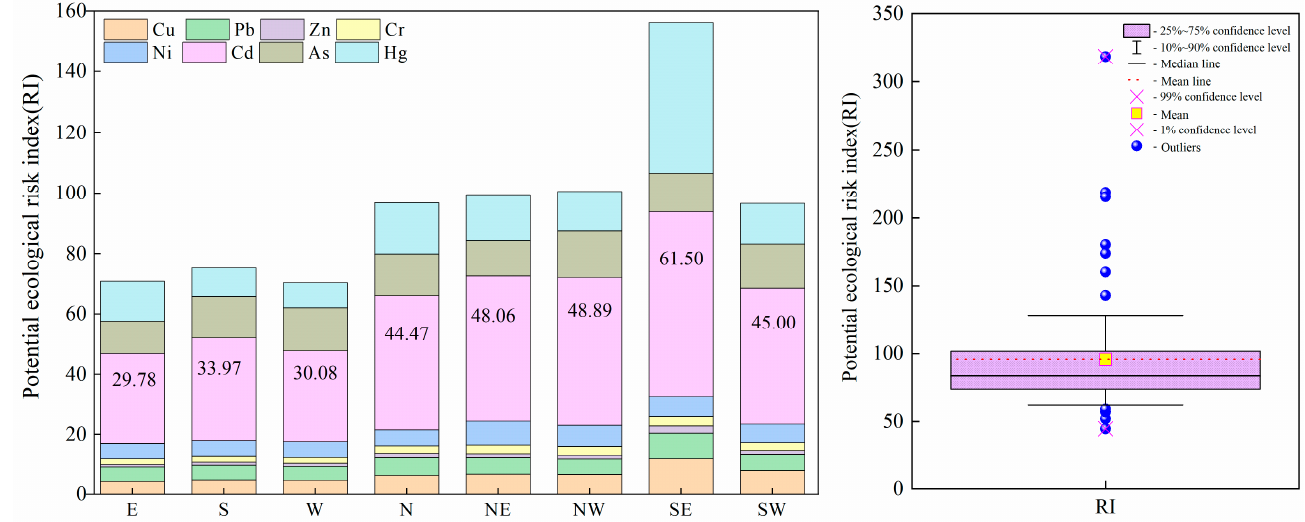
Figure 7. Ecological risk characterization of soil heavy metals in landfill.